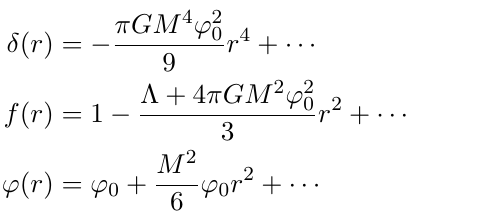
Figure 23 . Solutions f, ϕ, δ of Euclidean soliton when ϕ 0 is 0 . 5 / √ 2 . 849 / G ( r b = 5